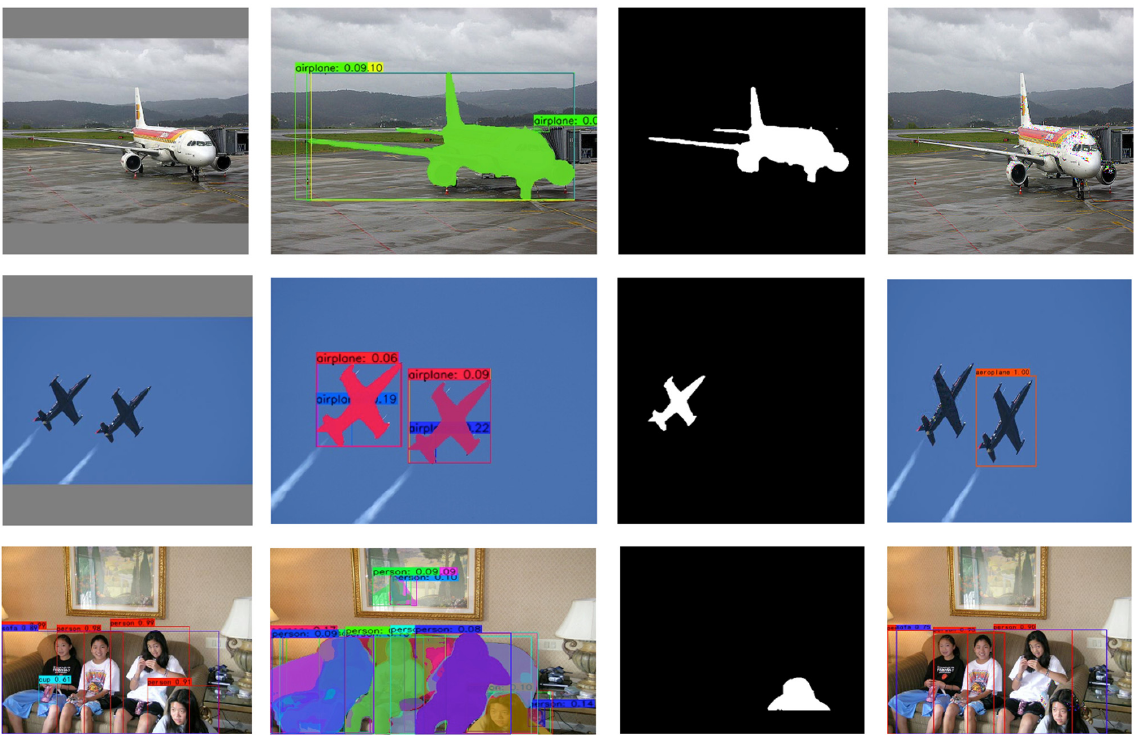
Figure 7. Comparison of adversarial examples to images with a different number of objects.